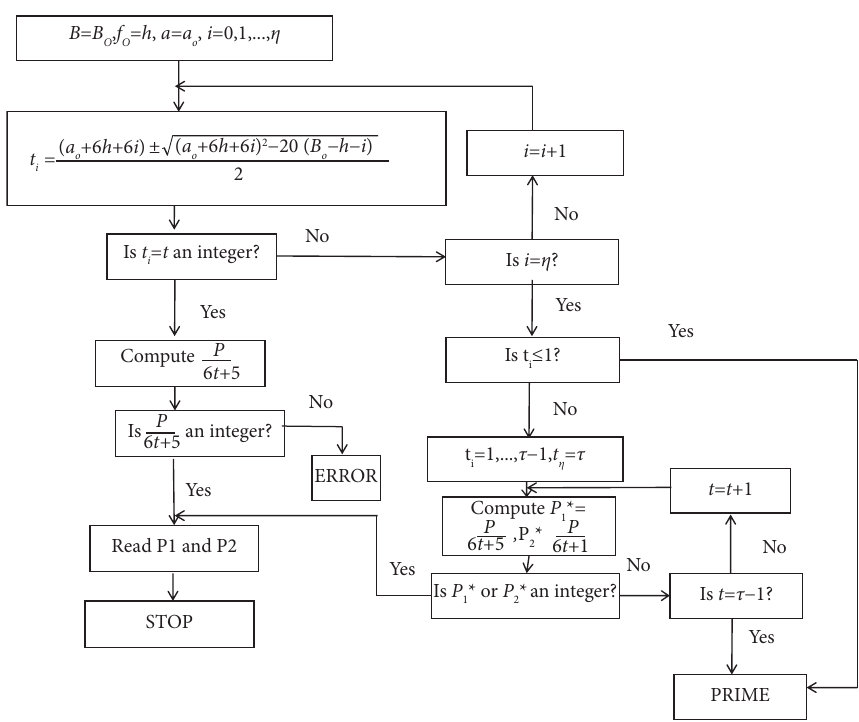
Figure 3: Algorithm for numbers of the form 6 k +5.